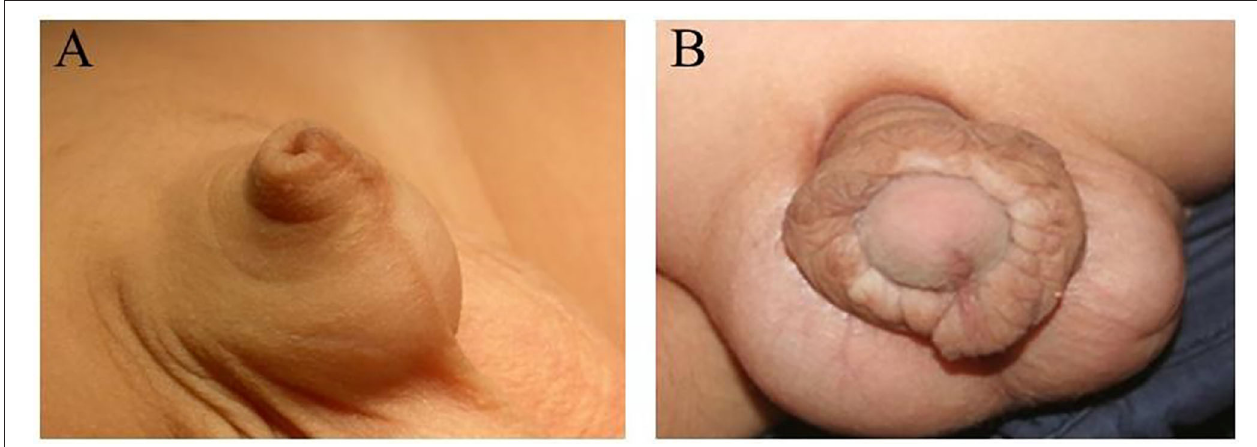
FIGURE 1 | (A) Typical appearance of the concealed penis. (B) Proliferation of inner plate of the prepuce after the reconstruction of concealed